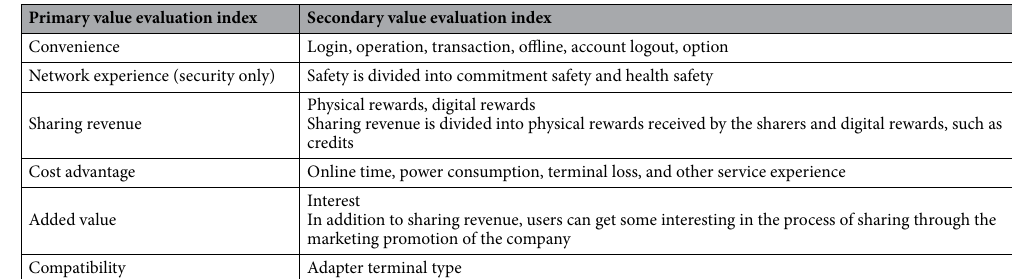
Table 4. Definition of the sharer value proposition